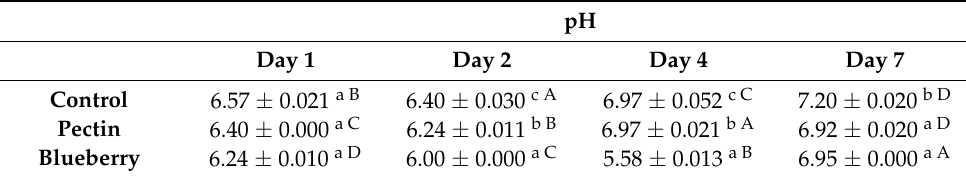
Table 4. pHs of salmon fillets during storage with different